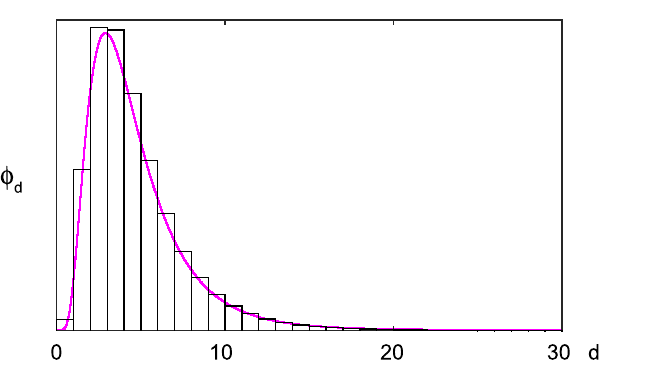
Fig 2. The distribution of transmission delays. A bar histogram represents the distribution of transmission delays on , which was converted from the log-normal distribution with the mean 4.7 days and SD 2.9 days (a a daily bases ϕ d magenta